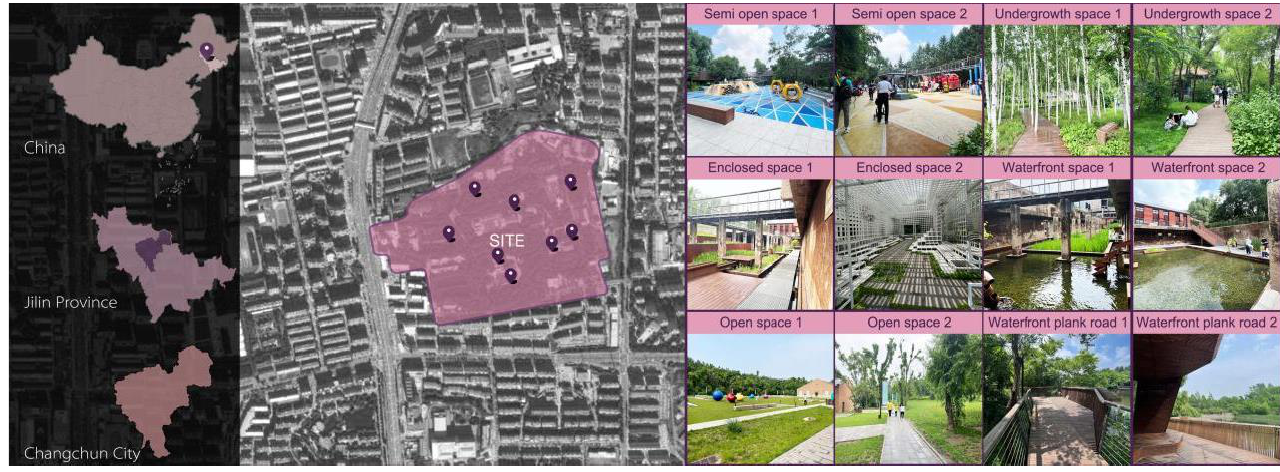
Figure 1. Map of the research site.